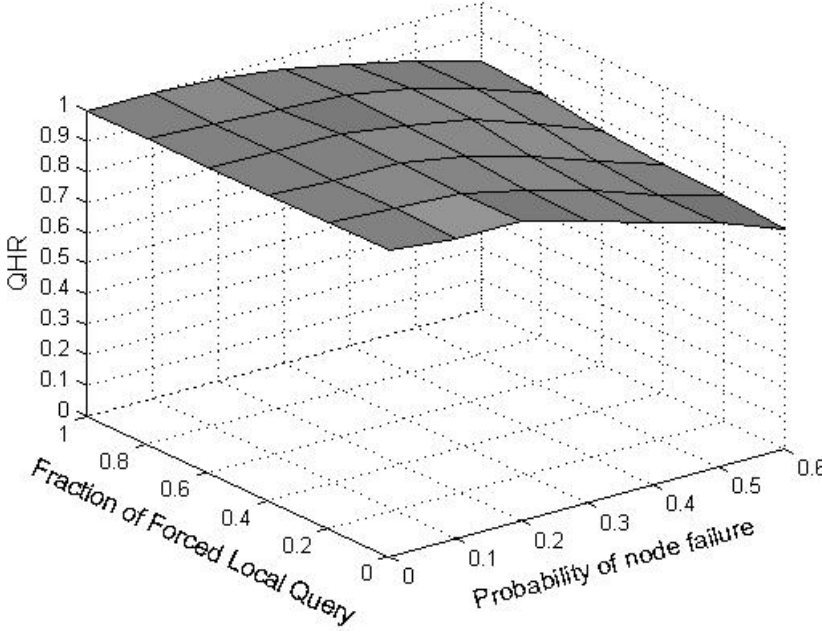
Figure 12. The QHR for SPEQs and probability node failure under different fraction of forced local queries.